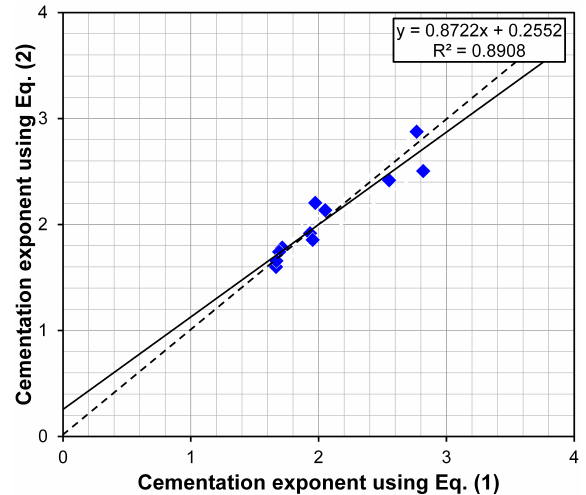
Figure 4. Cross-plot of the cementation exponents calculated using Eqs. (1) and (2) for a database of 3562 core plugs drawn from the producing intervals of 11 unattributable clean sandstone and car- bonate reservoirs. The solid line shows the least-squares regression and the dashed line shows the 1:1